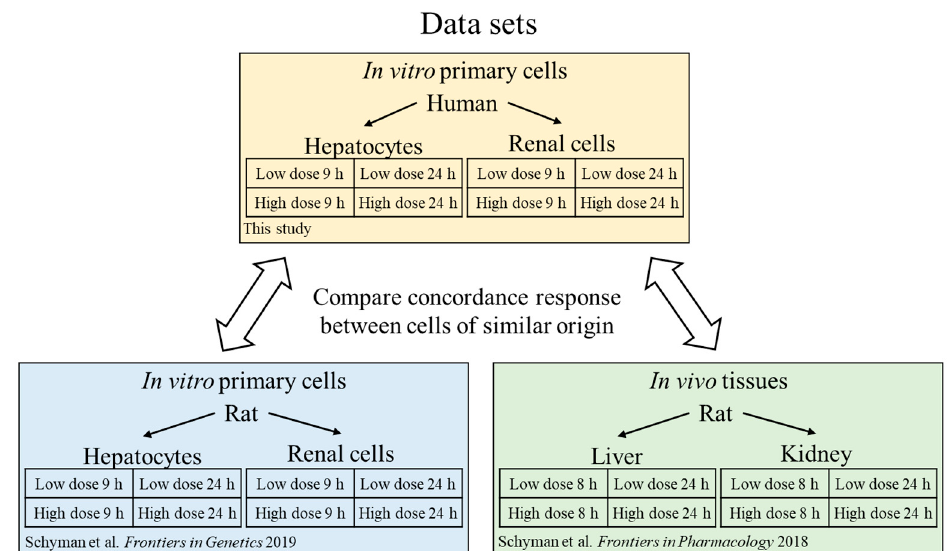
Figure 2. Data sets used in this study for comparing inter- and intra-species in vitro and in vivo cellular responses to low levels of thioacetamide exposures.